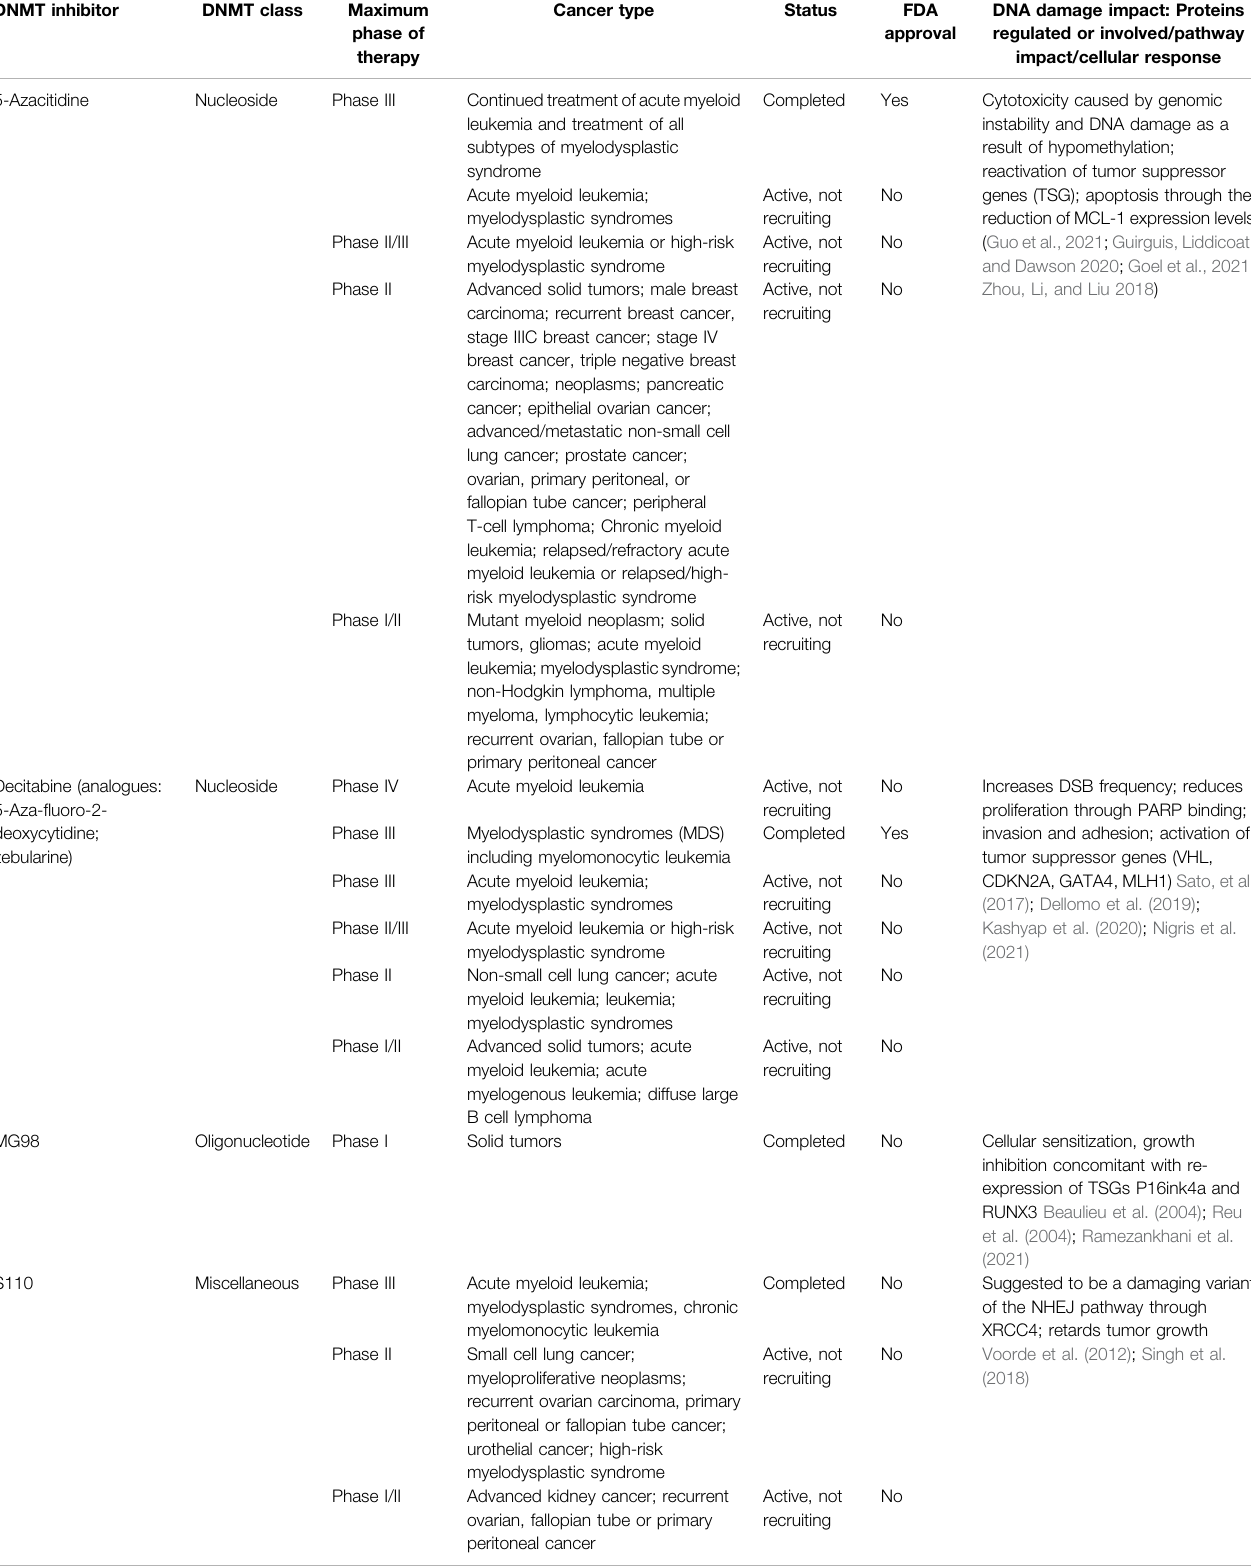
TABLE 2 | Most common DNA methyltransferase inhibitors that have been approved by the FDA or are currently undergoing clinical trials for the treatment of